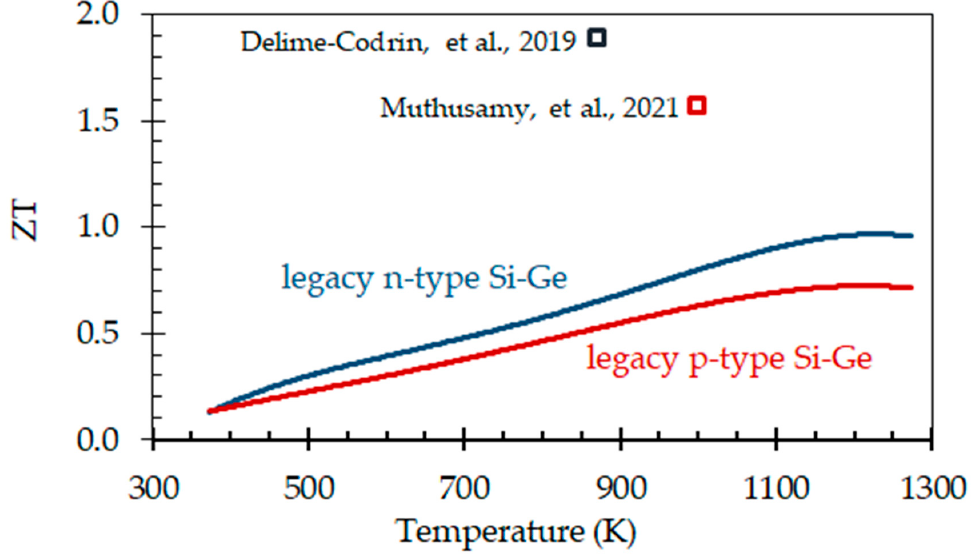
Figure 3. ZT vs. Temperature for n- and p-type legacy Si 78 Ge 22 . Examples of recent published results are shown for comparison.